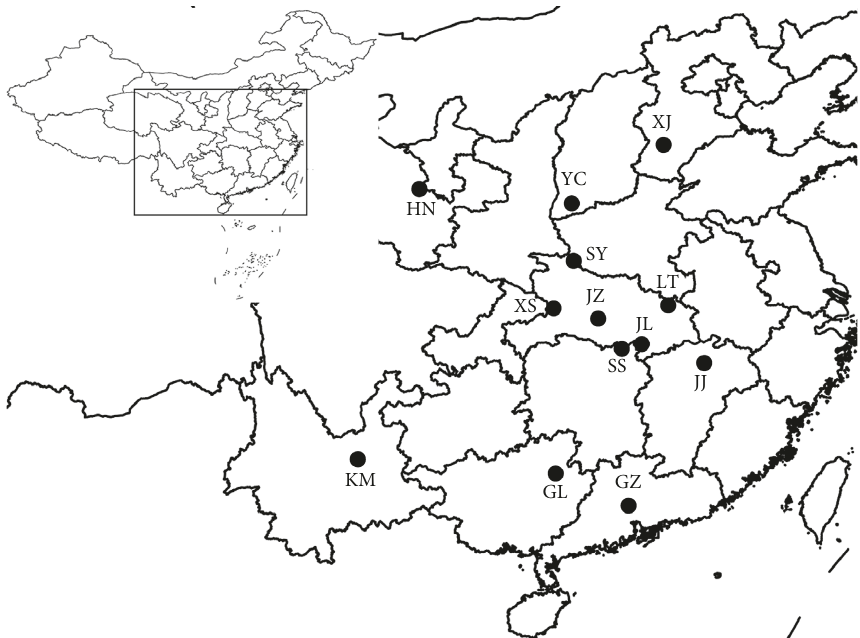
Figure 1: The geographic distribution of the selected 13 populations of Lycium chinense in